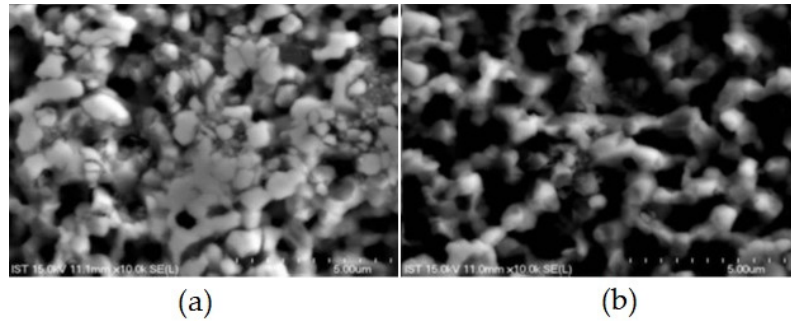
Figure 8. Sintered samples: KZM100-Y 2 O 3 (a) and BT02-Y 2 O 3 (b).